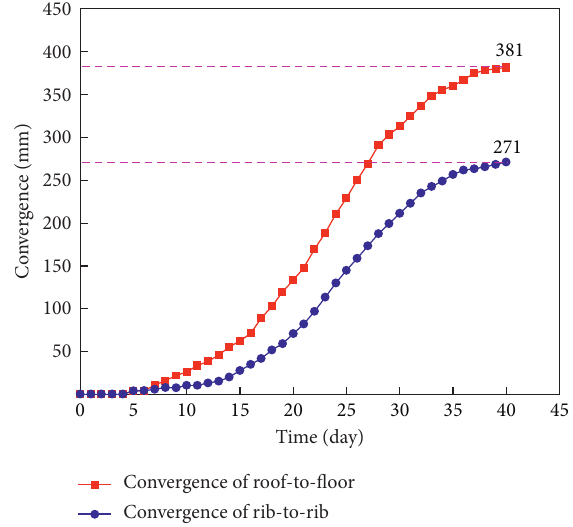
Figure 11: Deformation of the rock surrounding the